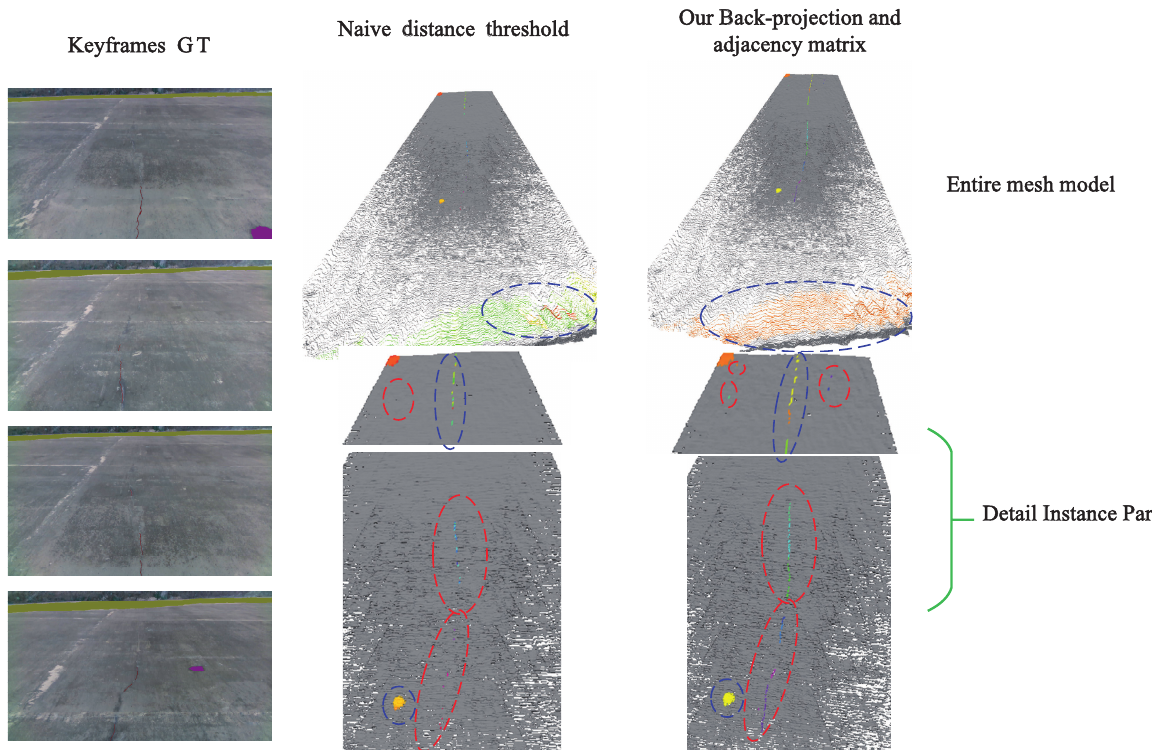
Figure 10. 3D instance reconstruction comparison. Keyframes GT using manual label to obtain defect segmentation; second and third columns compare naive distance TSDF and our back-projection with adjacency matrix approach, where the second and third rows show the details of instance recovery and reconstruction, the different instance of a class was in a different color. Red dotted circles show the recovery of class voxels, and blue dotted circles show the instance fusion of different classes. Our method shows better